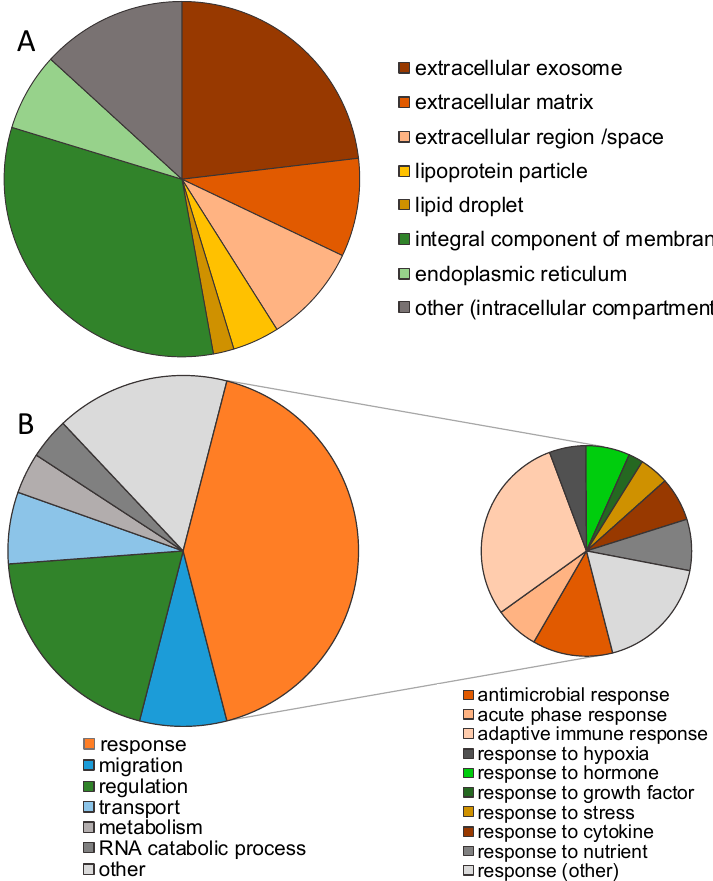
Figure 2. Assignment of peptides in the human milk peptidome to proteins (n = 212). ( A ) Protein localization and ( B ) protein function.